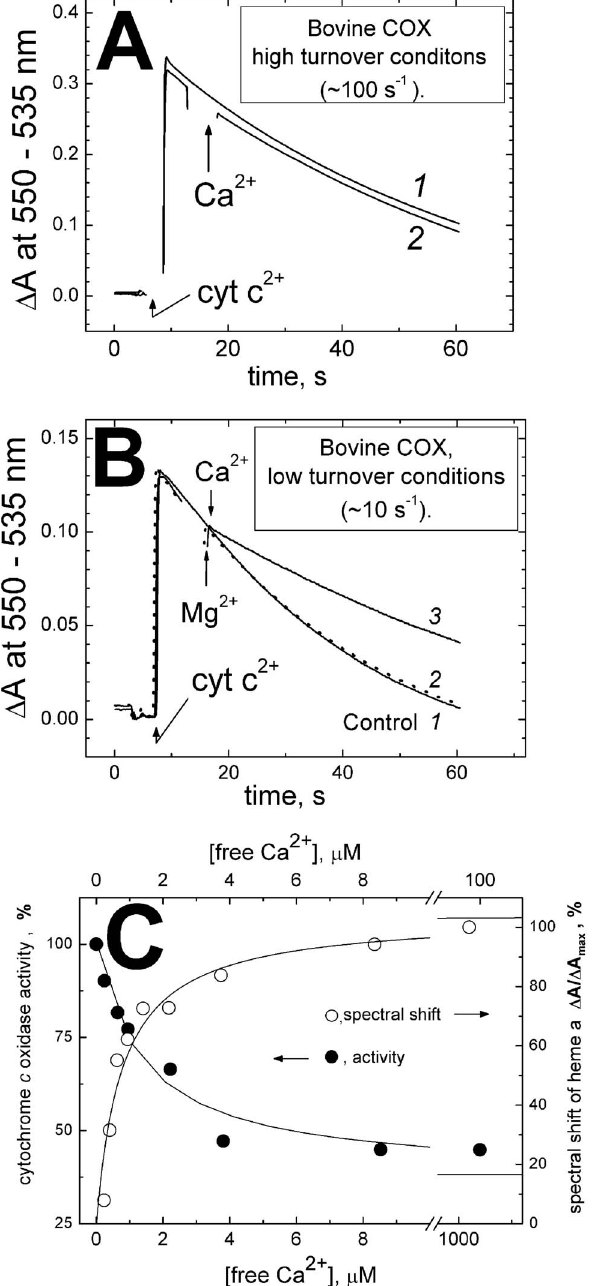
Figure 4. Inhibition of the ferrocytochrome c oxidase activity of bovine COX by Ca 2 + ions. ( A ) High-turnover conditions. 4 nM COX in the basic medium (with 50 mM choline chloride and 100 m M EGTA). 18 m M reduced cytochrome c is added and its subsequent oxidation is followed spectrophotometrically at 550 nm vs the 535 nm reference. Trace 1 , control recording; trace 2 , 200 m M CaCl 2 added where indicated. ( B ) Low-turnover conditions. Conditions as in ( A ), but choline chloride concentration increased to 0.5 M and 18 m M oxidized cytochrome c present in the buffer; COX concentration raised to 20 nM. Trace 1 (solid line), control recording; traces 2,3 : where indicated, 0.4 mM MgCl 2 (dashed line) or 200 m M CaCl 2 (solid line) are added. ( C ) Titration of the Ca 2 + -induced inhibition of COX activity and of the red shift of heme a spectrum. Cytochrome c 2 + oxidation was measured as in Panel B , trace 1 at different concentrations of free calcium buffered with 5 mM HEDTA. The initial rates were used to build